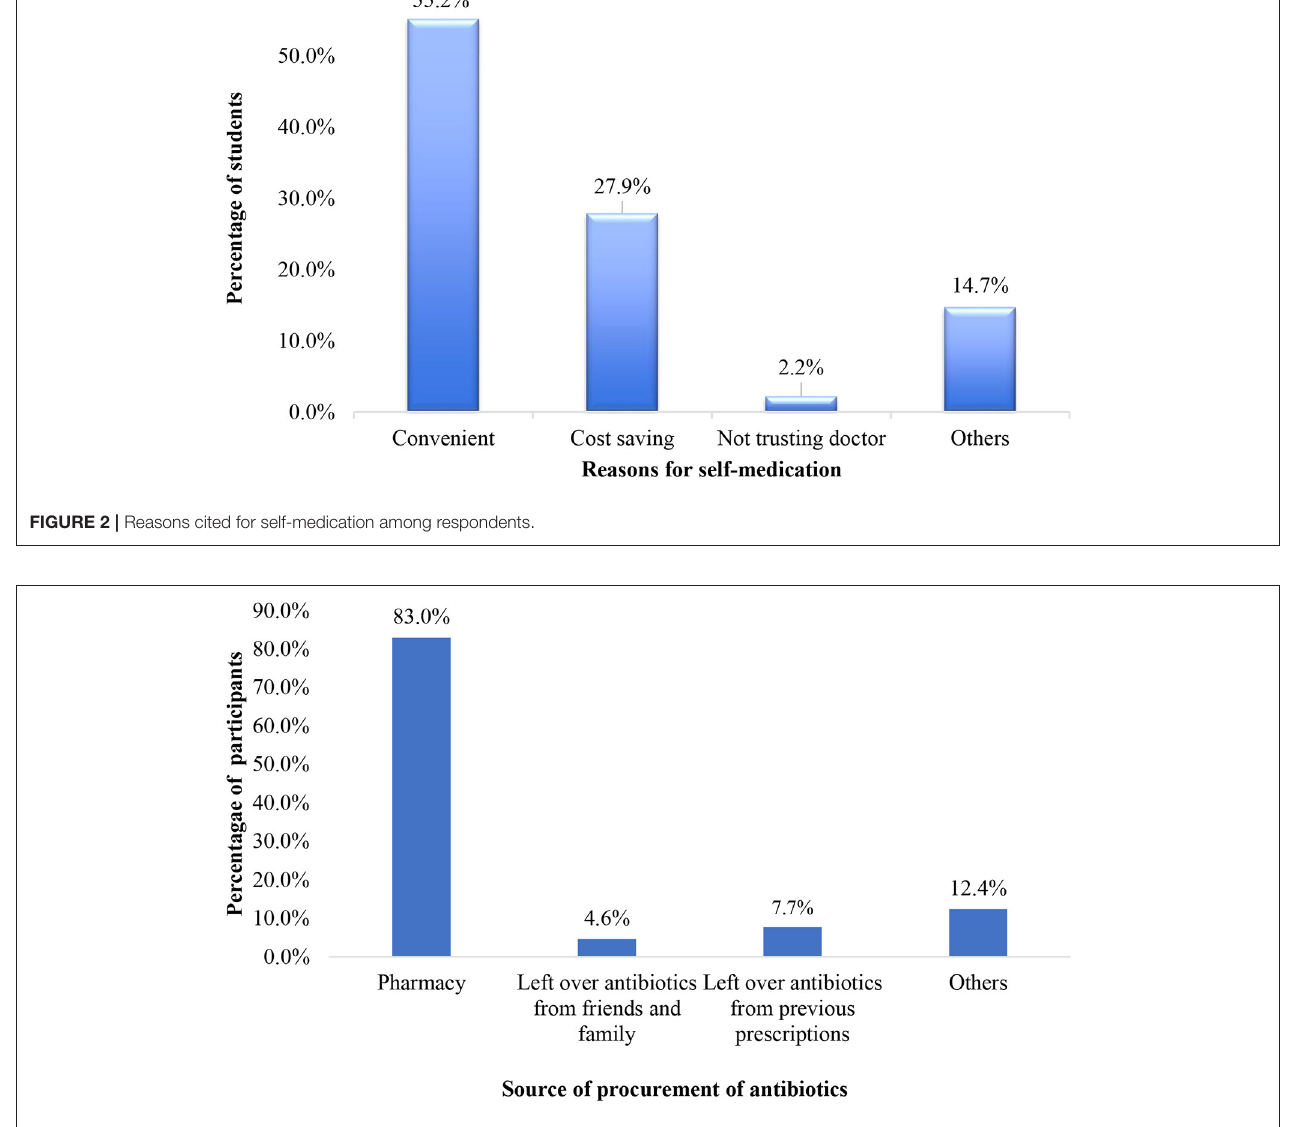
FIGURE 3 | Sources of procurement of antibiotics for self-medication among